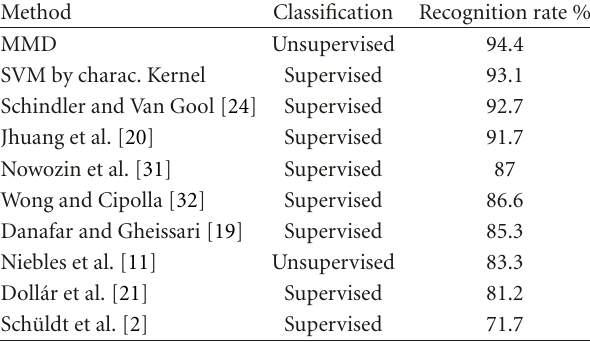
Table 2: Comparison of recognition results on KTH dataset with di ff erent approaches. Note that the recognition rate reported by Jhuang et al. [20] is obtained on video sequences from scenarios 1 and 4 only. Other reported rates are on all